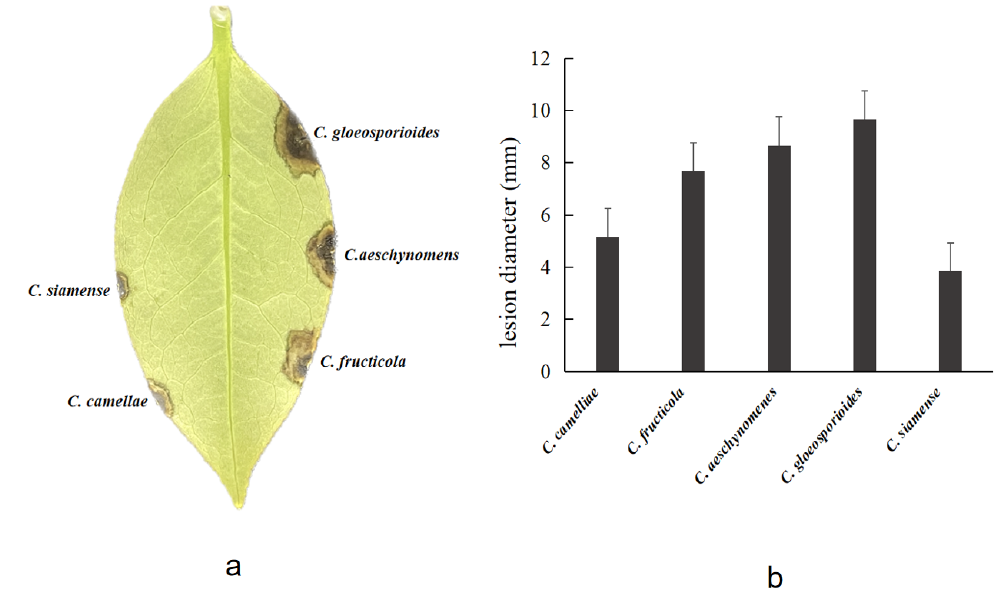
Figure 8. Pathogenicity of five Colletotrichum species from Ca. japonica leaves. ( a ) Induced symptoms on non-wounded Ca. japonica leaves after 3 days. ( b ). The virulence of the isolates was evaluated by measuring the diameters of the necrotic